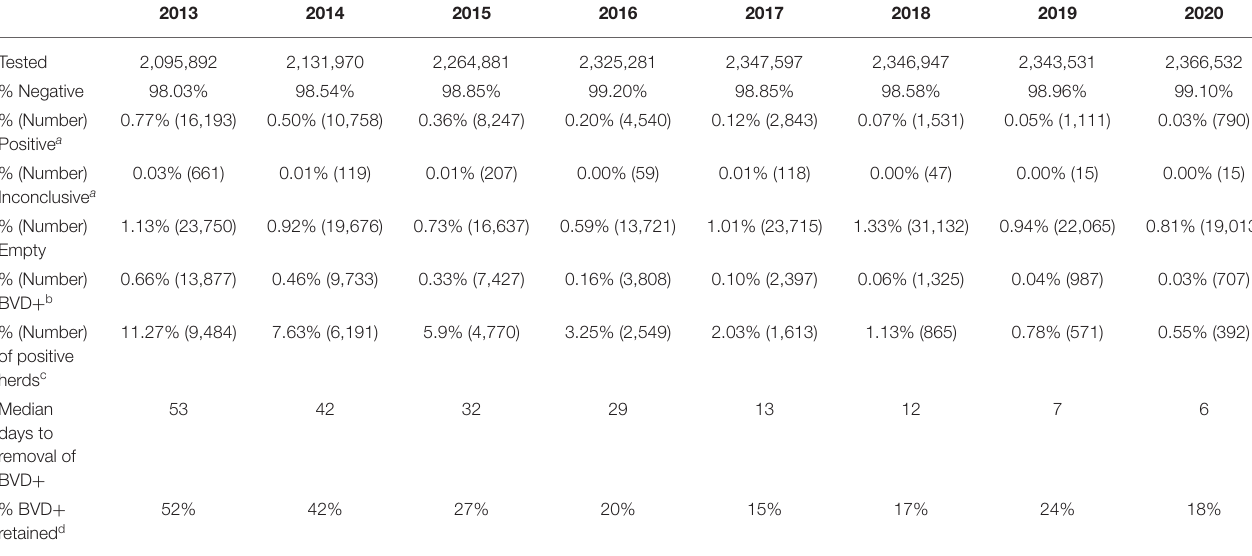
TABLE 2 | Summary of full-year results for calves born in each year of the